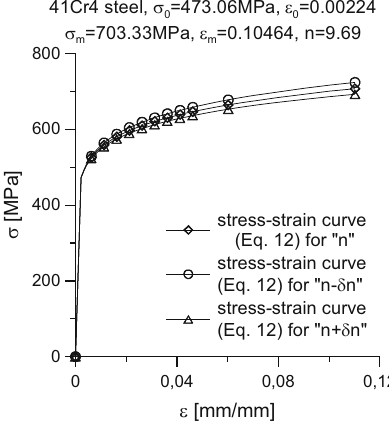
Figure A2: Comparison of the real stress – strain curve determined for the estimated value of the strain hardening exponent and the curves drawn based on the strain hardening exponent reduced or increased by the value of absolute ( example graph ) .